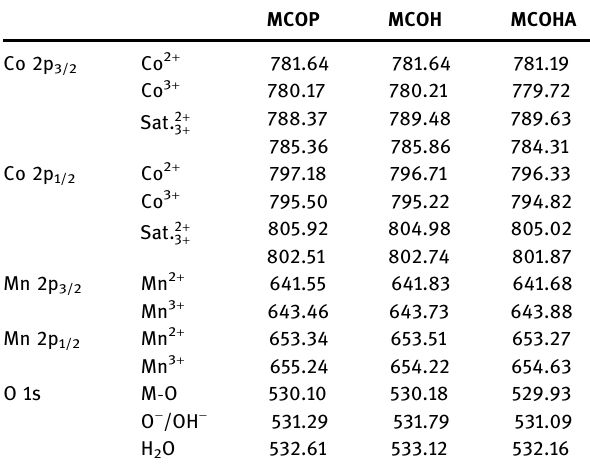
Table 1: Summary of XPS data for the